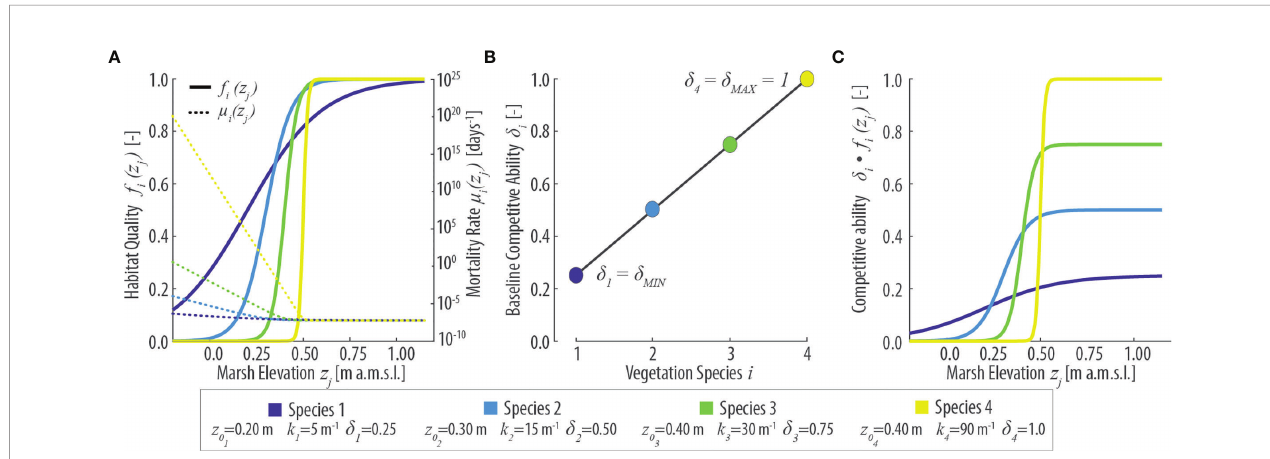
FIGURE 2 | Parametrization of vegetation features in the numerical model based on 4 virtual species. (A) Patterns of speci fi c habitat quality function f i (z j ) (continuous lines, left y-axis) and mortality rate µ i (z j ) (dotted lines, right y-axis) as a function of local marsh elevation (z j ) . (B) Baseline speci fi c competitive ability ( d i ) for different vegetation species i . (C) Speci fi c competitive ability [ d i f i ( z j )] as a function of local marsh elevation ( z j ). Values of the parameters z 0 reported in the lower